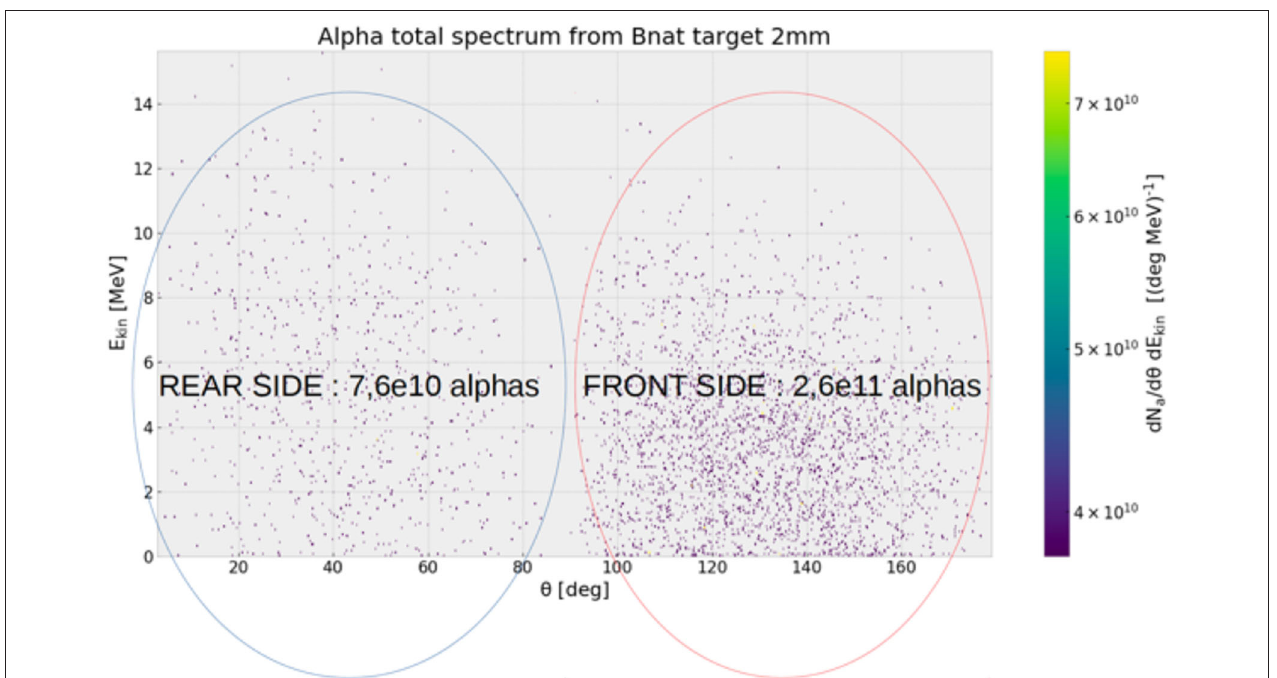
FIGURE 6 | α -particle angular distribution produced from 2-mm-B target obtained from SMILEI-FLUKA simulations.